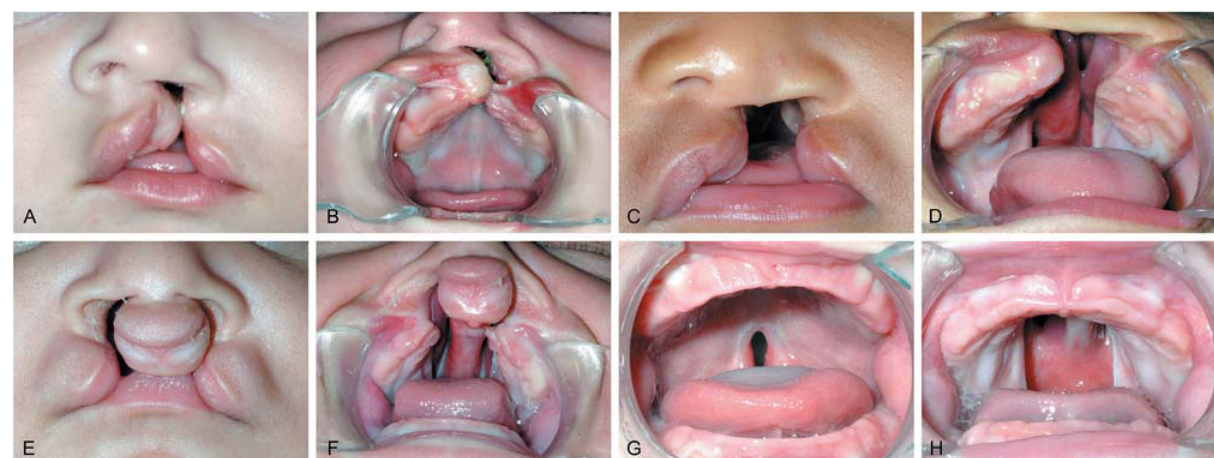
Figure 1- A and B - Complete unilateral cleft lip affecting the lip, alveolar ridge and anterior palate; C and D - Complete unilateral cleft lip and palate (affecting the lip, alveolar ridge and primary and secondary palate); E and F - Complete bilateral cleft lip and palate (affecting the lip, alveolar ridge and primary and secondary palate); G - Incomplete cleft palate (involving only the soft palate and uvula) and H - Complete cleft palate (completely involving the secondary palate)